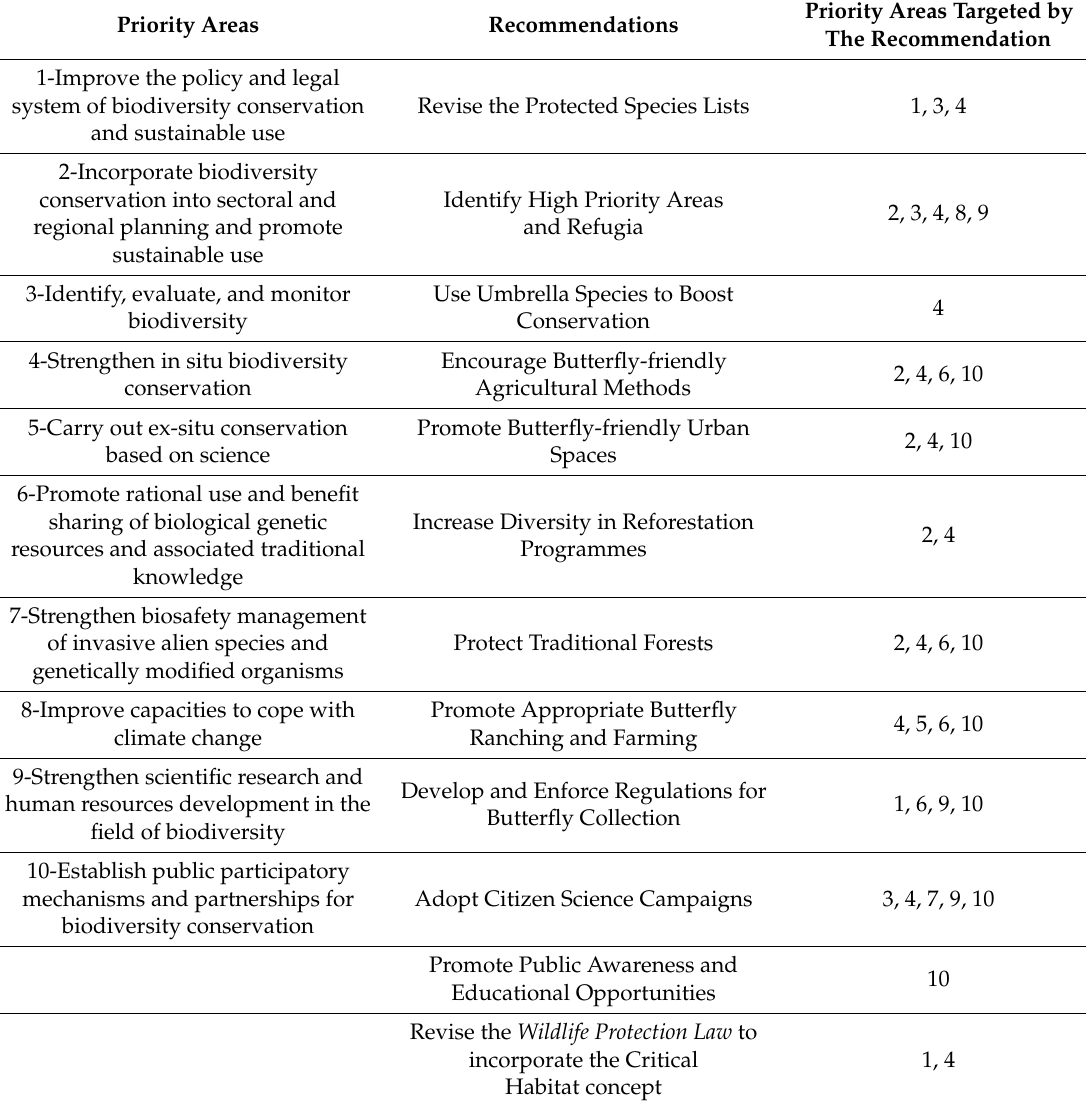
Table 4. Overlaps between our Recommendations and the Priority Areas of the China National Biodiversity Conservation Strategy and Action Plan